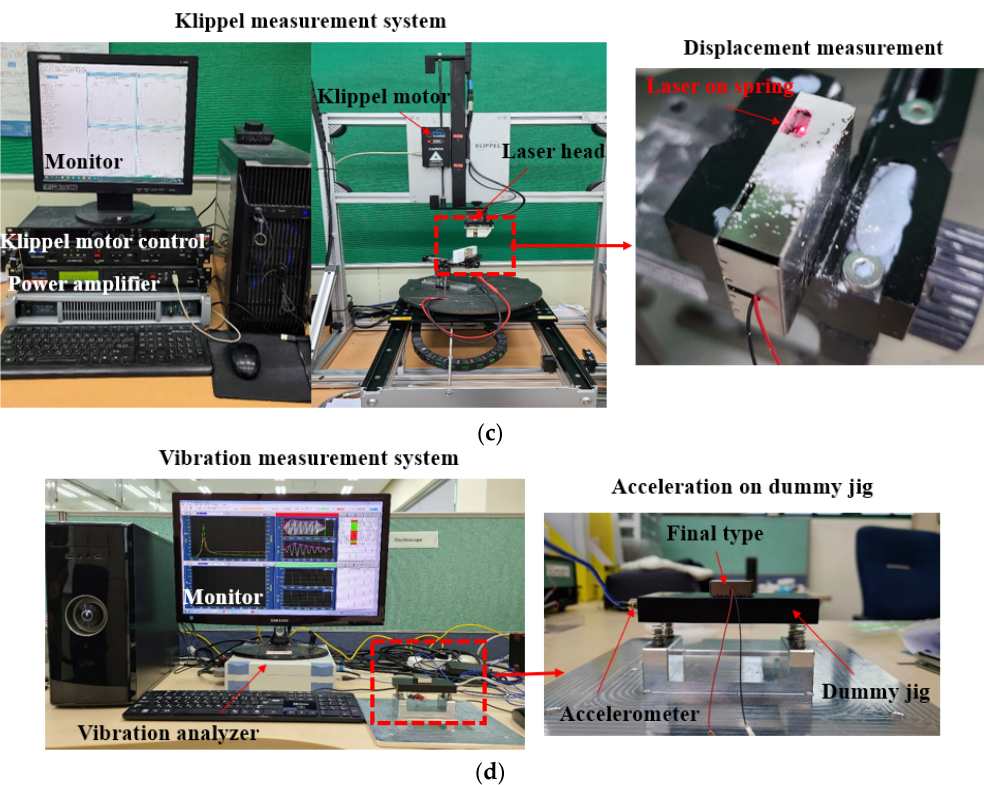
Figure 8. Sample comparison and experimental setups: ( a ) prototype sample and final type sample; ( b ) parts of sample; ( c ) displacement measurement setup; and ( d ) acceleration measurement setup.